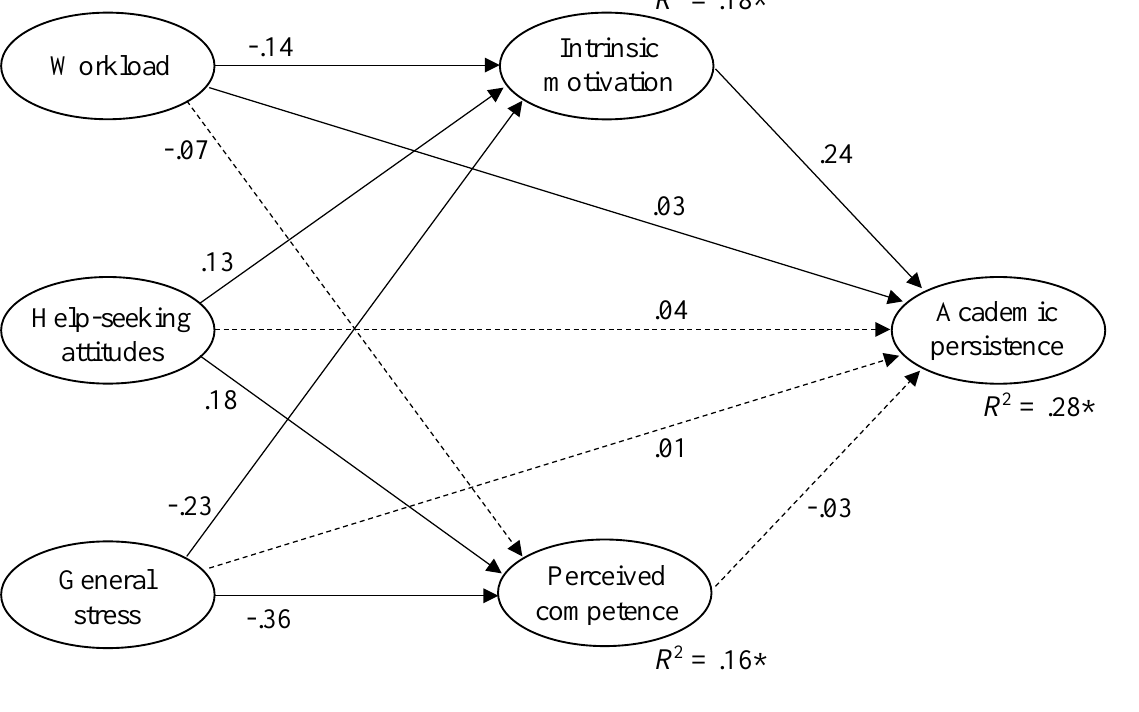
Figure 2 . Structural equation model. Solid lines represent significant paths, p < .05. Path coefficients are unstandardized. For clarity, the measurement model is not presented. R 2 = explained variance. * p <